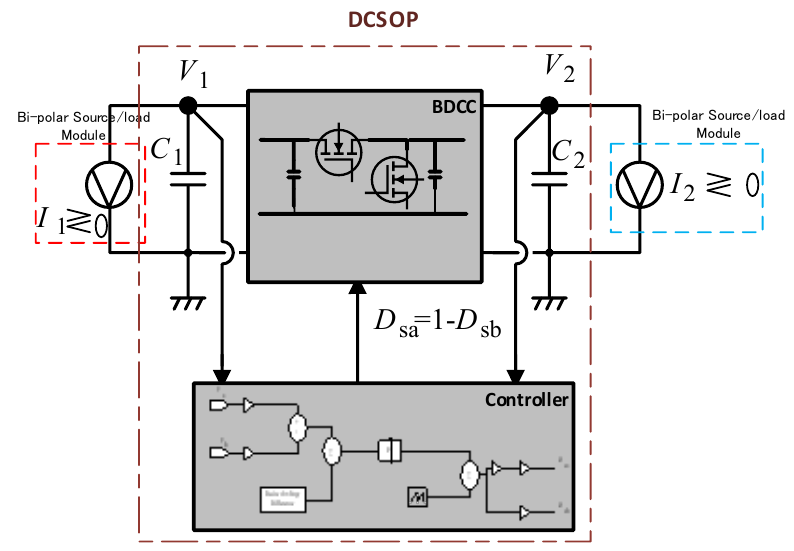
Figure 10. Configuration for the DCSOP stress test.